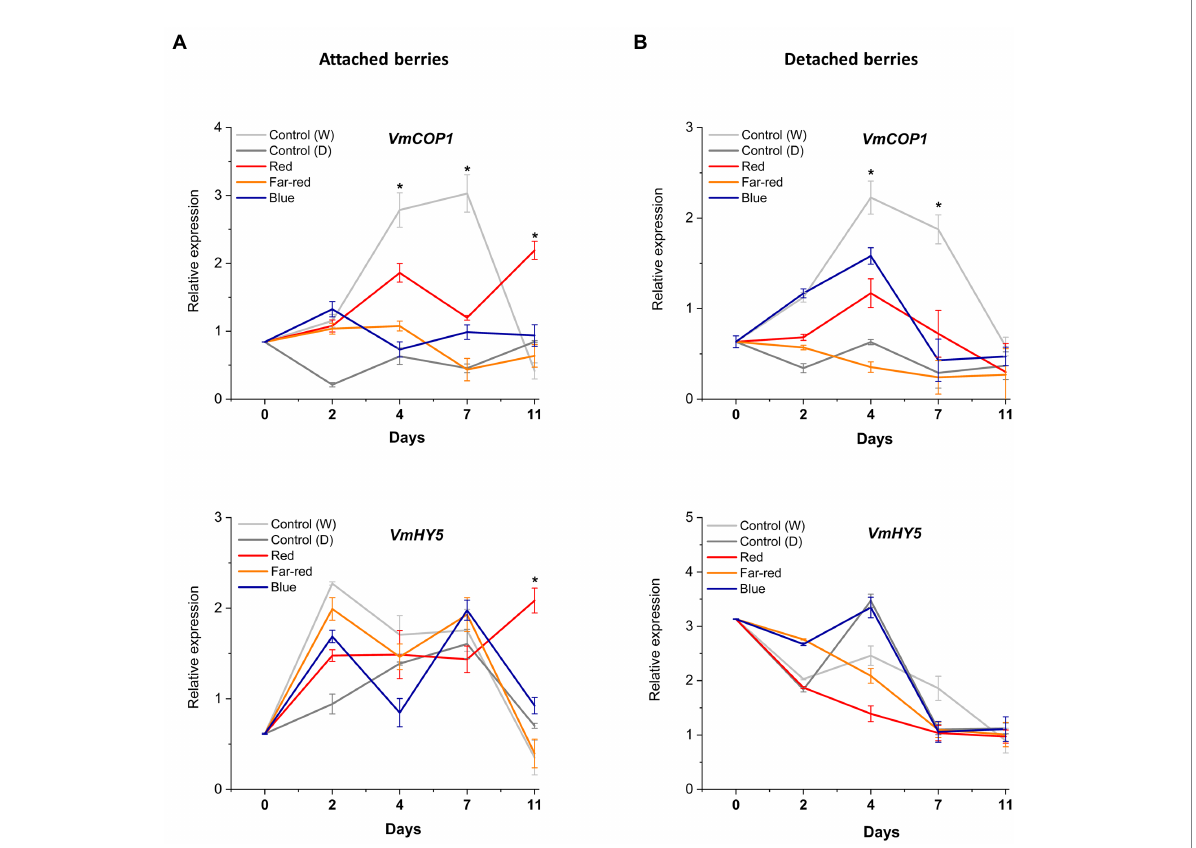
FIGURE 7 Effect of light spectral treatments on the expression of photomorphogenesis related genes ( VmCOP1 and VmHY5 ) in attached berries (A) and in detached berries (B) . The expression levels were normalized to the housekeeping gene VmGAPDH or actin . Expressed in average of three biological replicates ±SE and significant differences between control and light treatments were analyzed by comparison of means using Student’s t -test (indicated in asterisks*) with value of p ≤